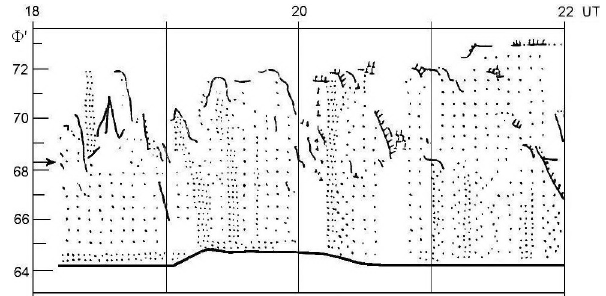
Figure 33a. Auroral dynamics on the meridian of Dixon Island ob- servatory on 3 December 1973. Positions of homogeneous auroral forms (arcs or bands) are shown by solid lines; that of rayed arcs by herringbones; diffuse aurorae by dots (Sergeev and Vorobjev, 1979).